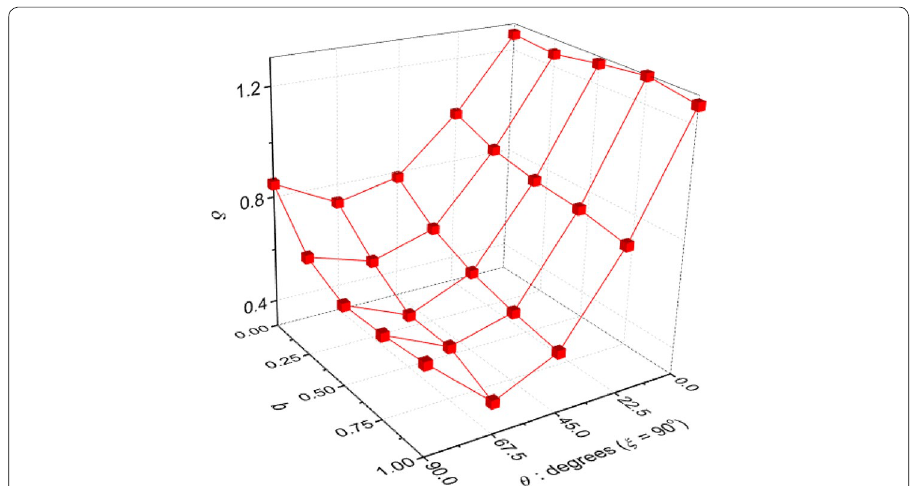
Fig. 8 The spatial angle δ of Nevada sand as a function of b and ϑ values from Lade et al.’s [27] tests